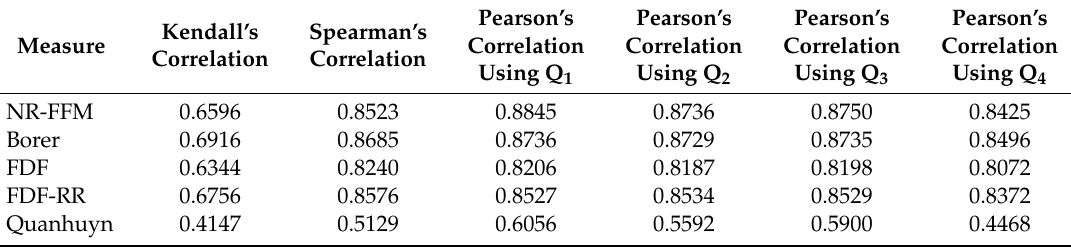
Table 13. Kendall’s, Spearman’s, and Pearson’s correlation for the VQEG dataset—28 degraded video sequences (best values are marked in